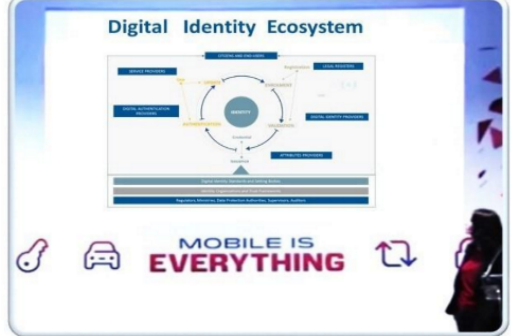
Fig. 1. The global momentum to endow each individual with a digital identity may be an appropriate vehicle to embed individual personal security agents